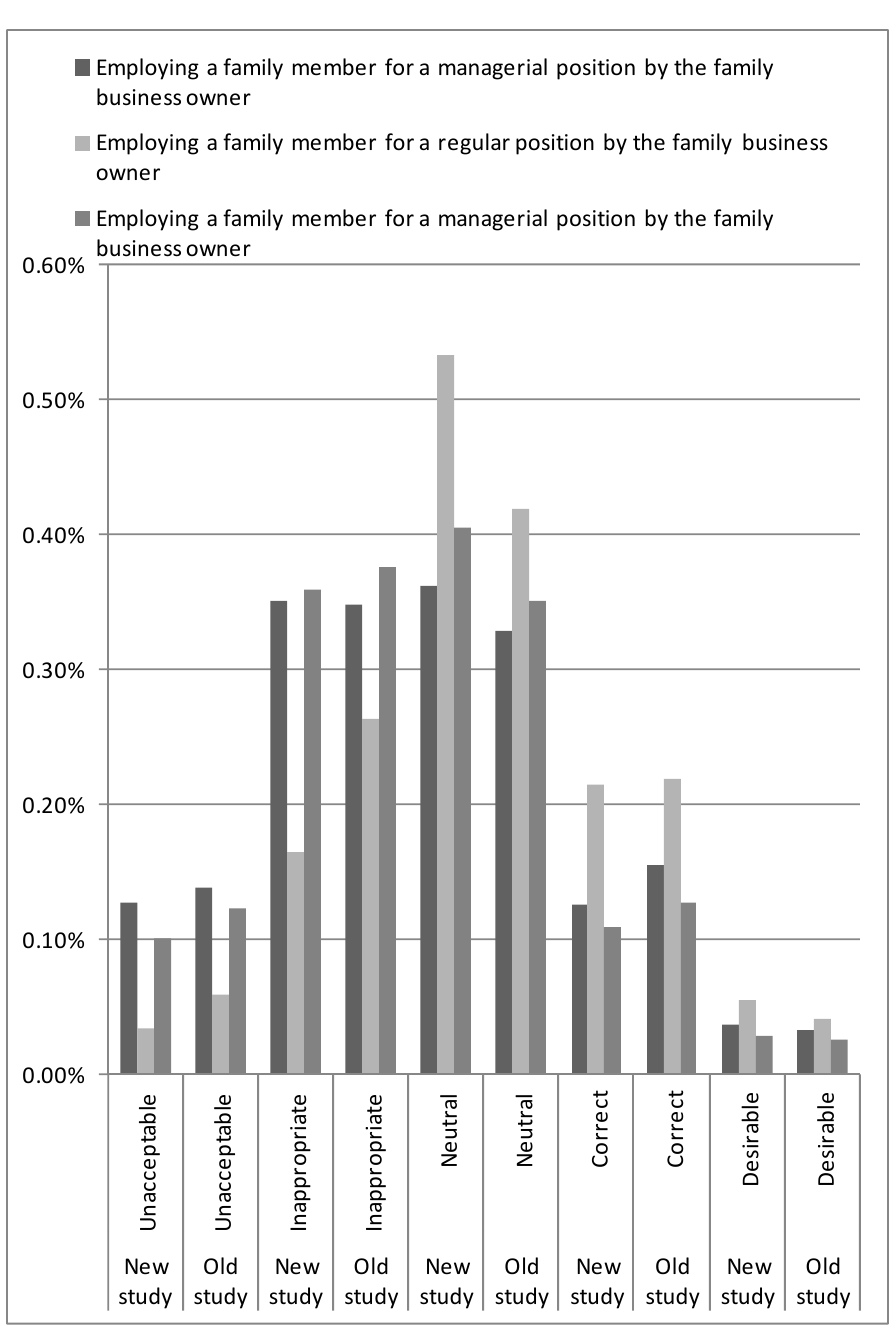
Figure 3. Assessment of the employment situation by means of nepotism and cronyism in a family business. Source: authors’ own elaboration.